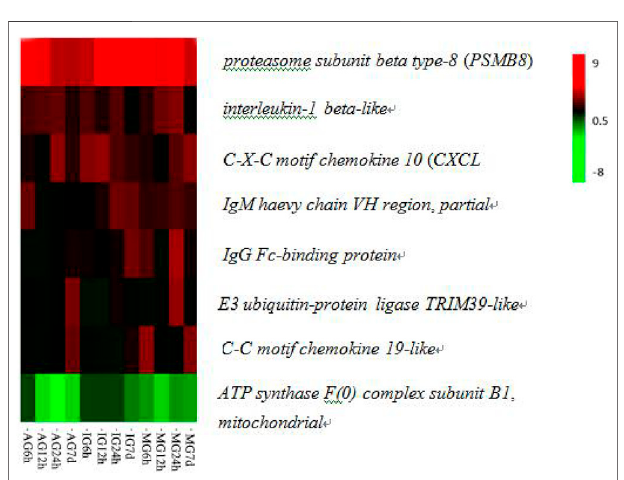
FIGURE 2 | Hierarchical clustering of eight DEGs related to immune responses in the O. niloticus intestine.